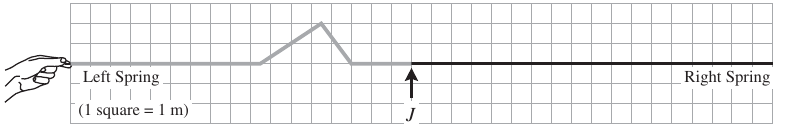
FIG. 3. Sequence of questions: Pulse at a junction between two different